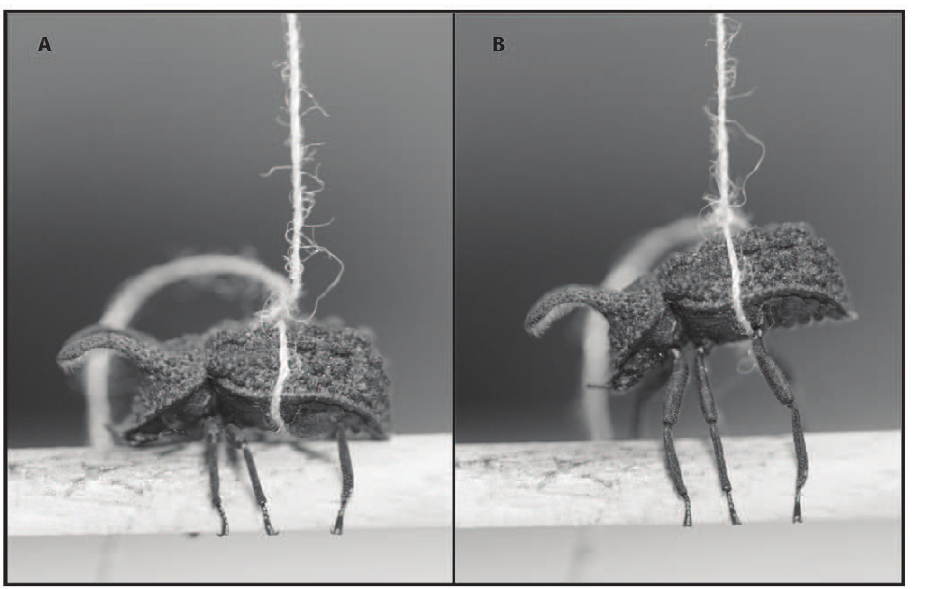
Figure 2. A large male B.cornutus undergoing a grip strength trial. (A) The male grips the dowel rod in a similar fashion to how males grip females during courtship and guarding in the wild. (B) The same male at maximum resistance just before releasing the dowel rod.